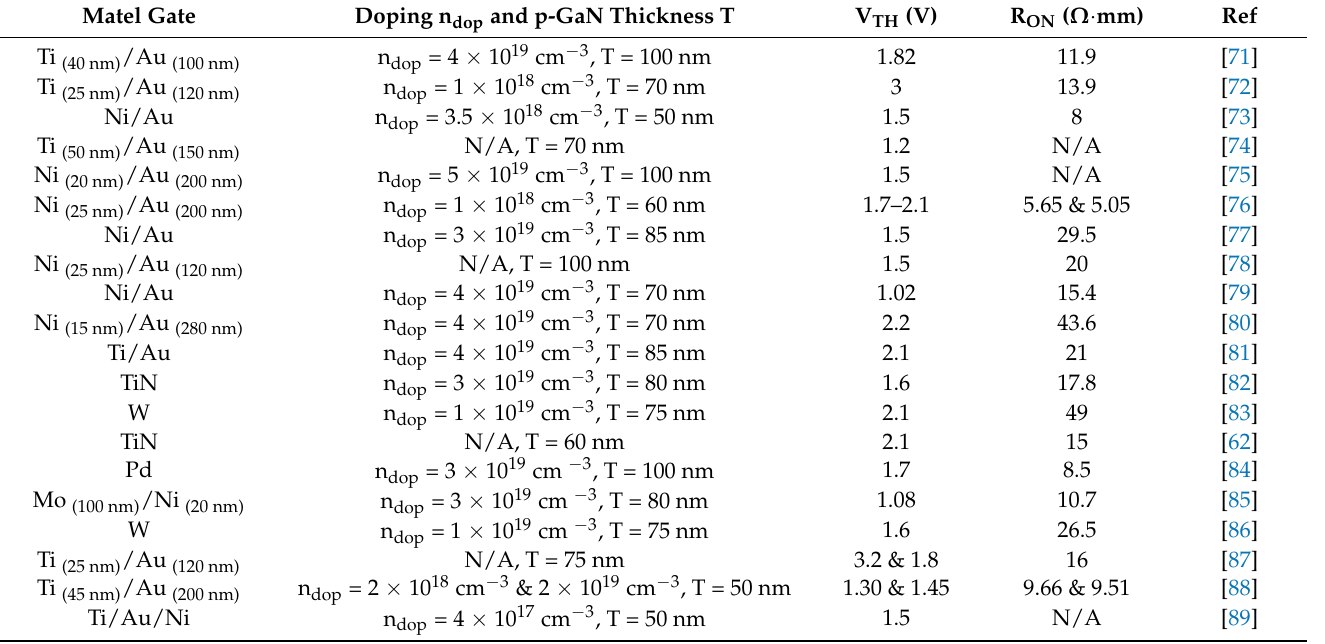
Table 3. Survey of literature data on different Schottky Contact.